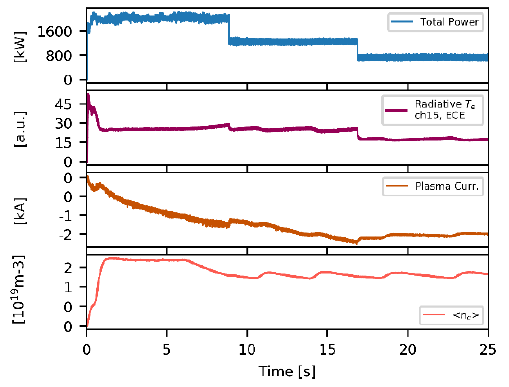
Figure 1: Reference discharge without current drive. Temperature and plasma current changes are due to modifications of the total injected power (blue timetrace).